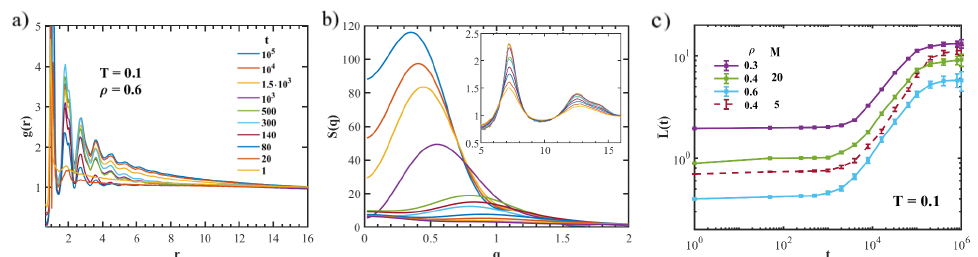
Figure 2. Panel ( a ): radial distribution function g(r), for a sample at T = 0.1, ρ = 0.6, at different aging times t. Panel ( b ): Corresponding static structure factor S ( q ) . Panel ( c ): Time evolution of the average domain size L ( t ) for systems with different density quenched at T = 0.1. For comparison, data for a system with M = 5 are also shown (dashed